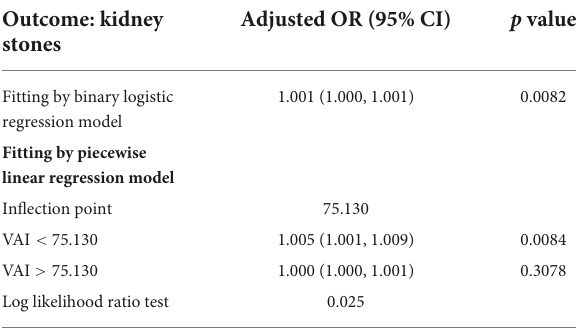
TABLE 3 Results of binary logistic regression and piecewise linear regression.*